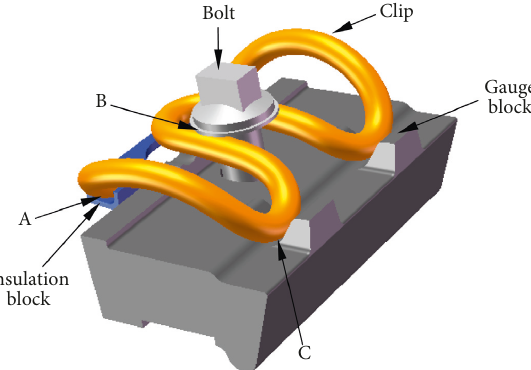
Figure 7: Fastening with the ω -type rail